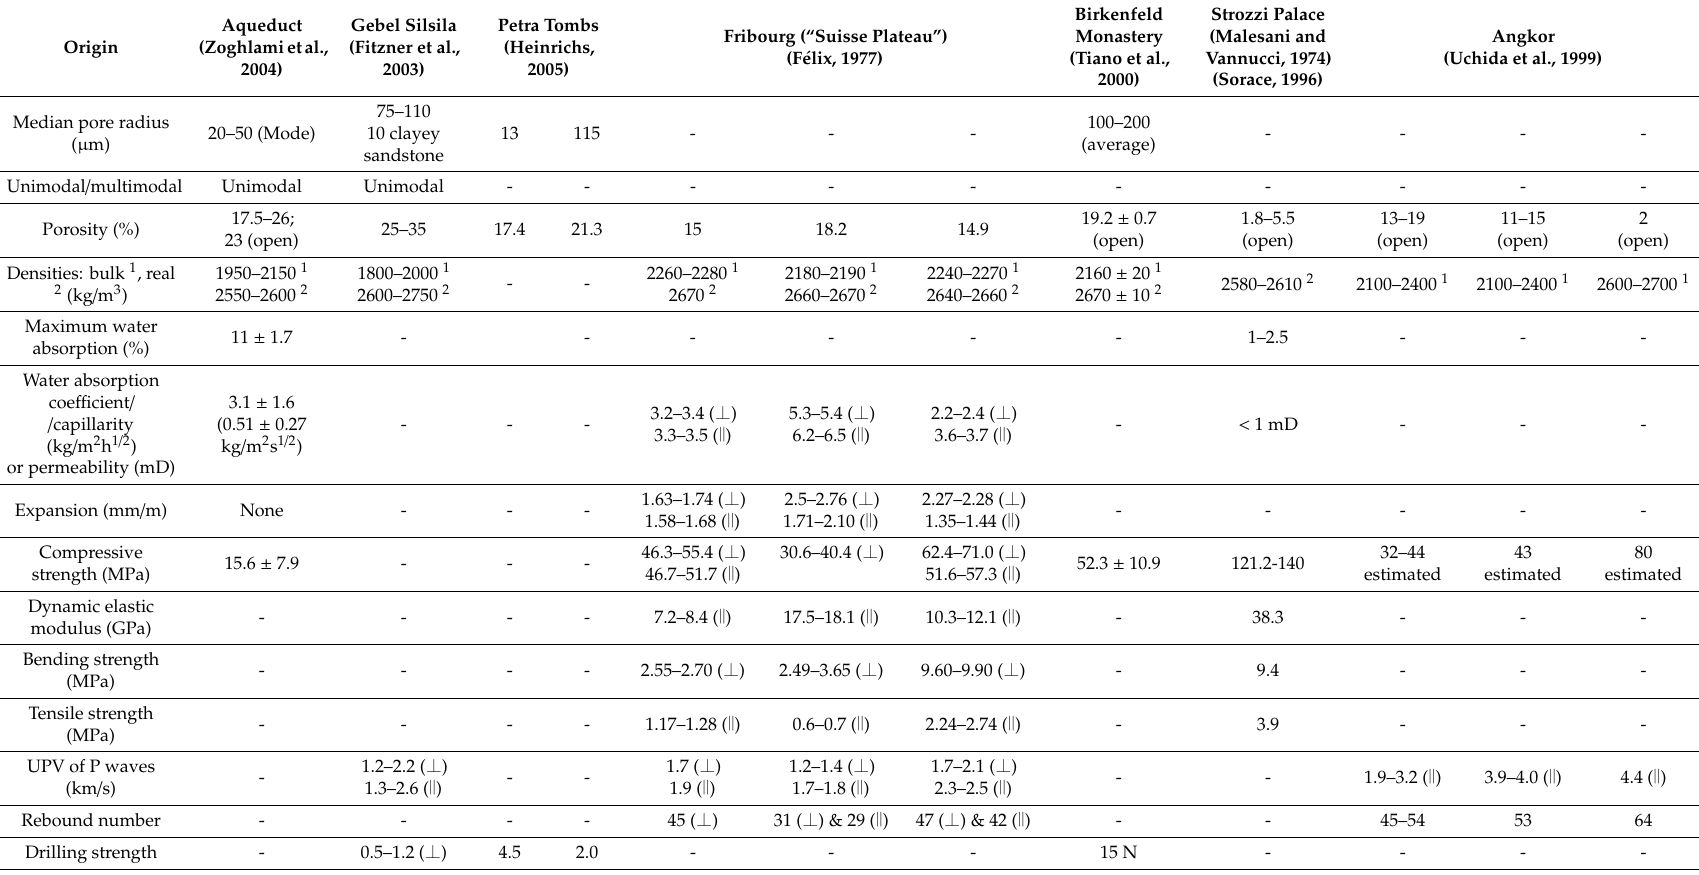
Table 2. Physical and mechanical properties of building sandstones of world cultural